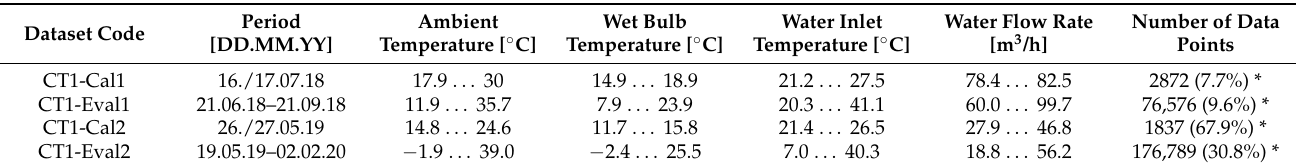
Table 5. Overview over the datasets of CT1 used for model calibration and evaluation; ranges are marked with “MIN . . . MAX”.